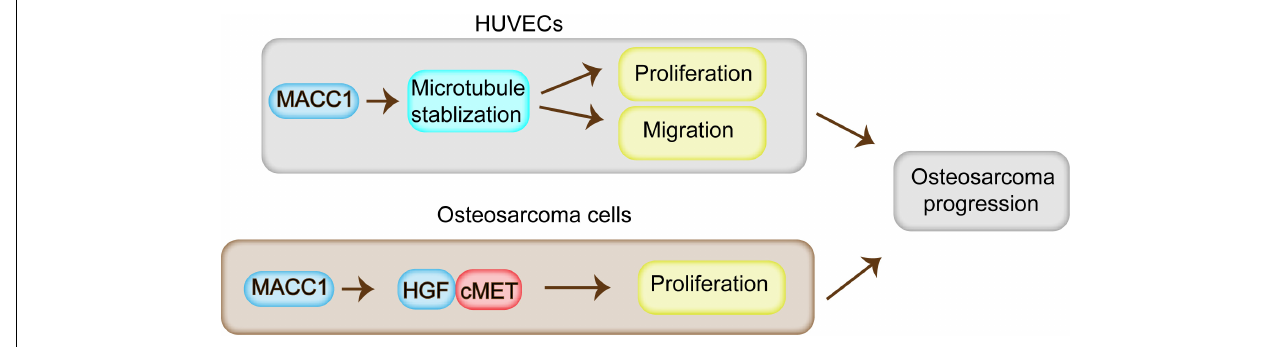
FIGURE 6 | Model for the regulatory role of MACC1 in osteosarcoma progression. MACC1 promotes cell proliferation through the HGF/c-Met pathway, and contributes to the proliferation, migration, and angiogenesis of endothelial cells via the regulation of microtubule stability, which further promotes osteosarcoma